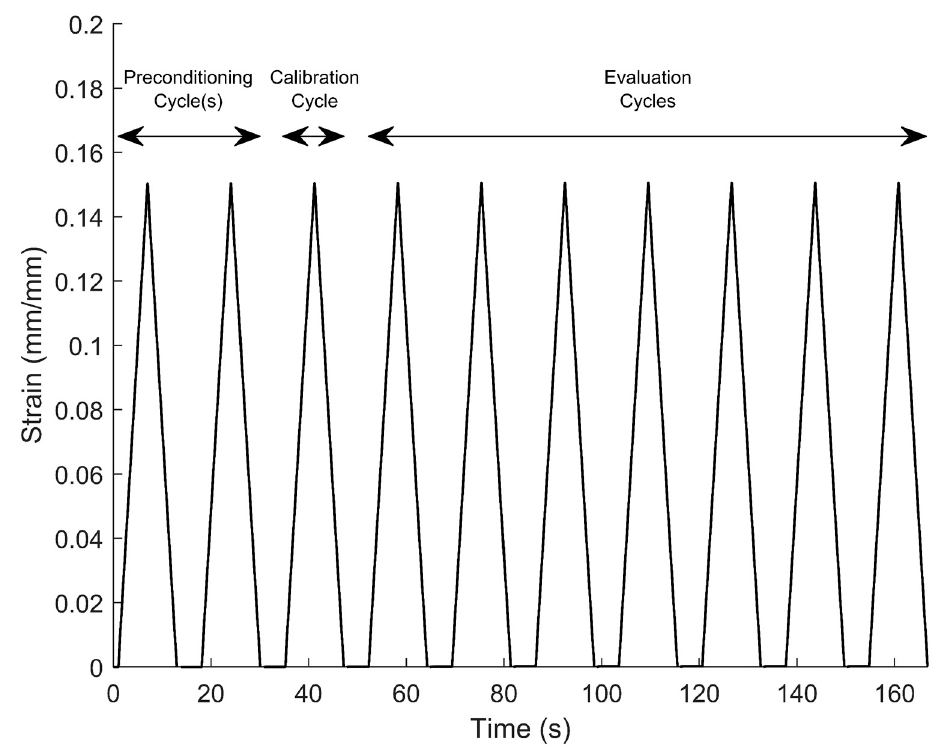
Figure 3. Depiction of the strain profile that the tensile tester applied to a sensor, and which cycles constituted preconditioning, calibration, and evaluation of stress relaxation.